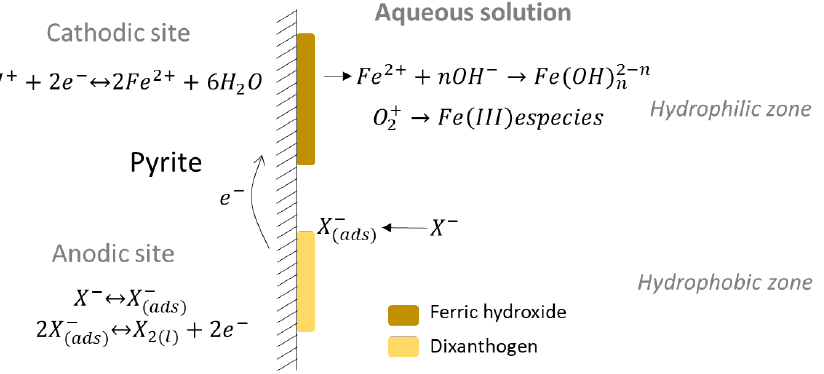
Figure 25. Adsorption and formation of dixanthogens on the surface of non-activated pyrite (adapted from Valdivieso et al. [115]).